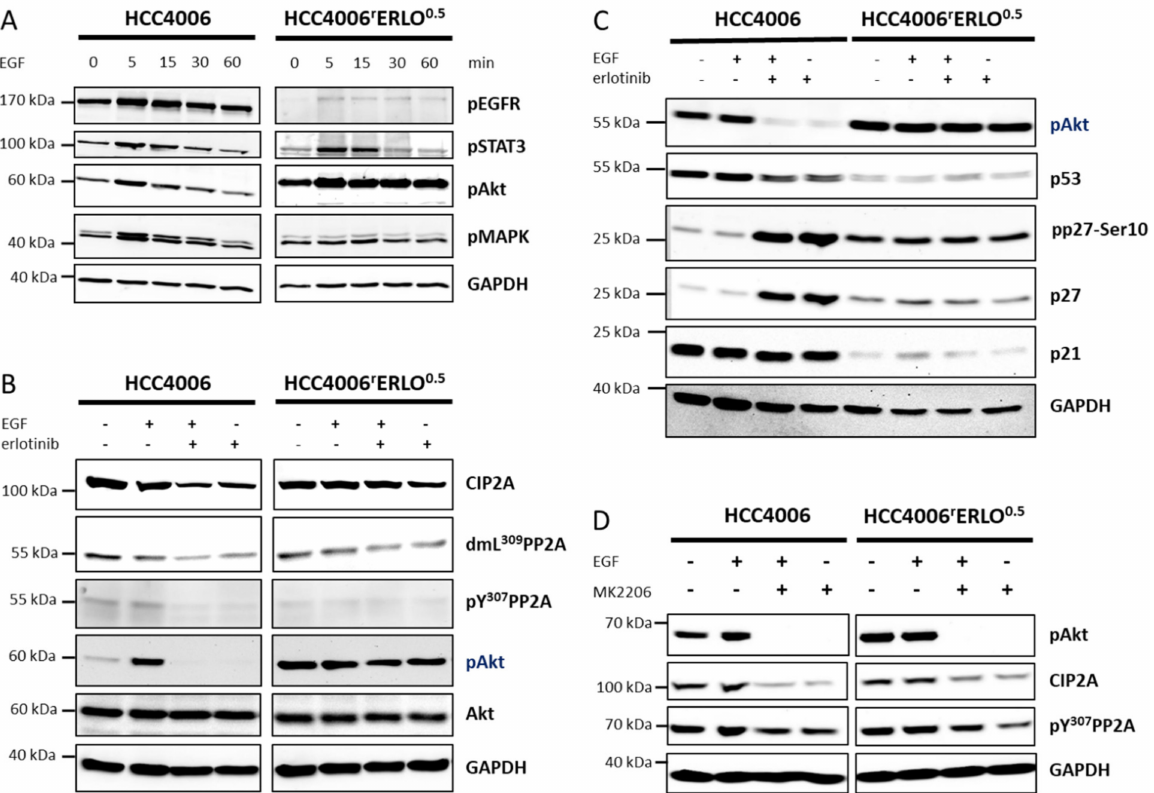
Figure 2. Akt signaling is constitutively active in HCC4006 r Erlo 0.5 cells adapted to grow in the presence of 0.5 µ M erlotinib. Cells were ( A ) incubated with 100 ng/mL epidermal growth factor (EGF) for the depicted times, ( B , C ) preincubated with 1 µ M erlotinib for 24 h before adding 100 ng/mL EGF for another 30 min, or ( D ) preincubated with 20 µ M MK2206 for 24 h before adding 100 ng/mL EGF for another 30 min. Proteins were separated on a 10% polyacrylamide gel and blotted on a nitrocellulose membrane, and specific target proteins were detected using target specific primary and species-specific secondary antibodies, coupled with horseradish peroxidase, as listed in the methods section. Signals were developed using a chemoluminescence substrate and detected with the ChemoCam System (Intas, Göttingen, Germany). A representative blot of at least three biological replicates is